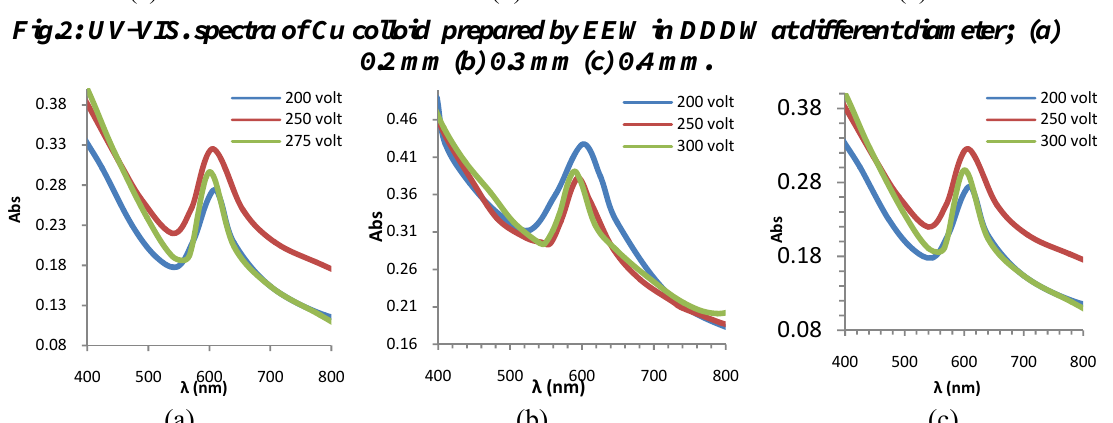
Fig.2: UV-VIS. spectra of Cu colloid prepared by EEW in DDDW at different diameter; (a)